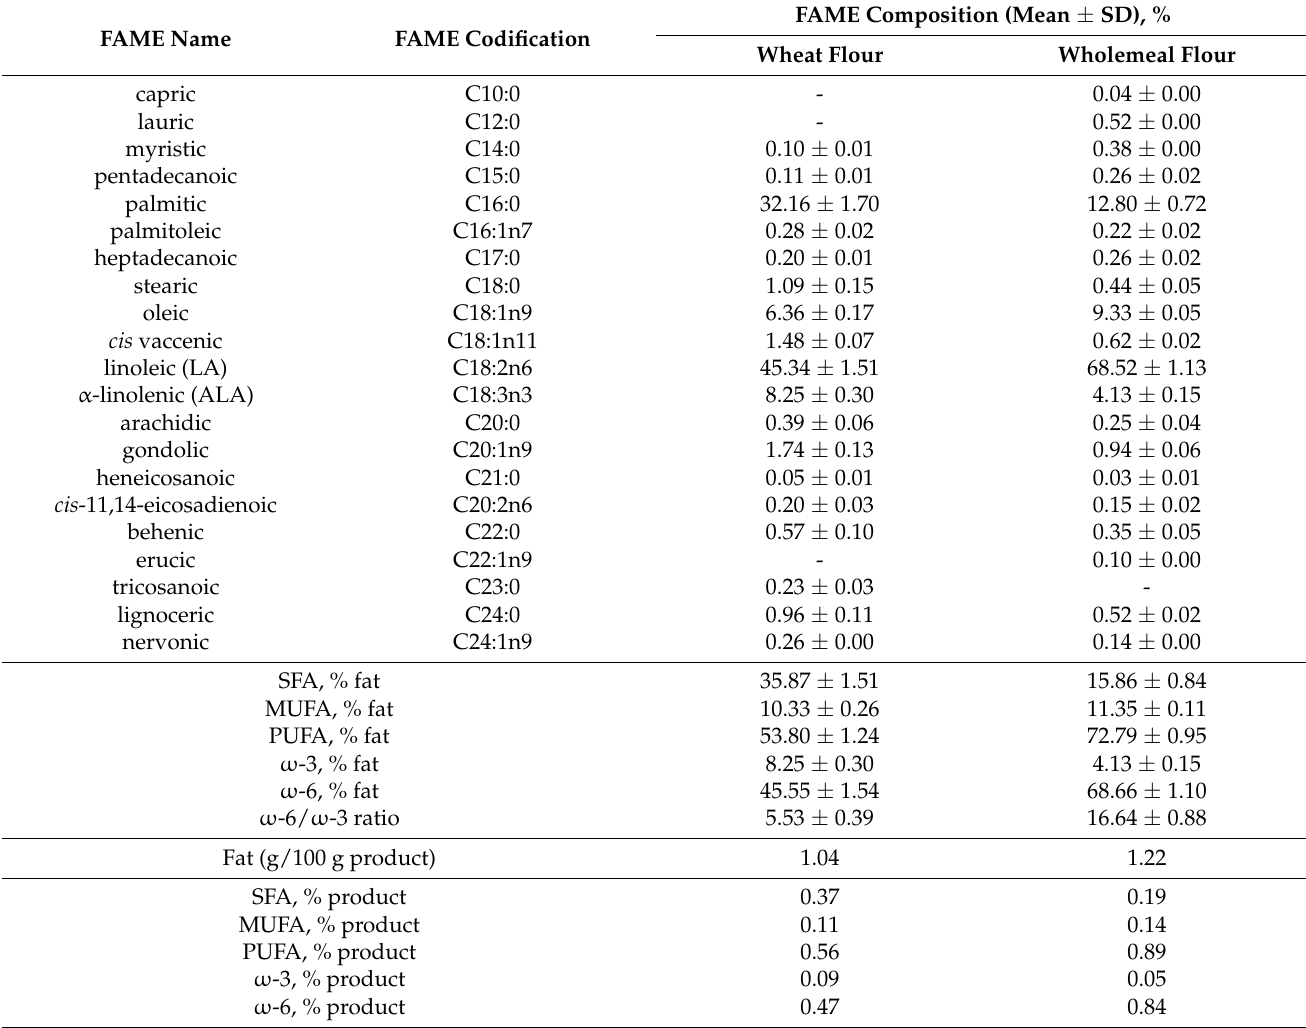
Table 5. Fatty acid methyl esters content of wheat flour